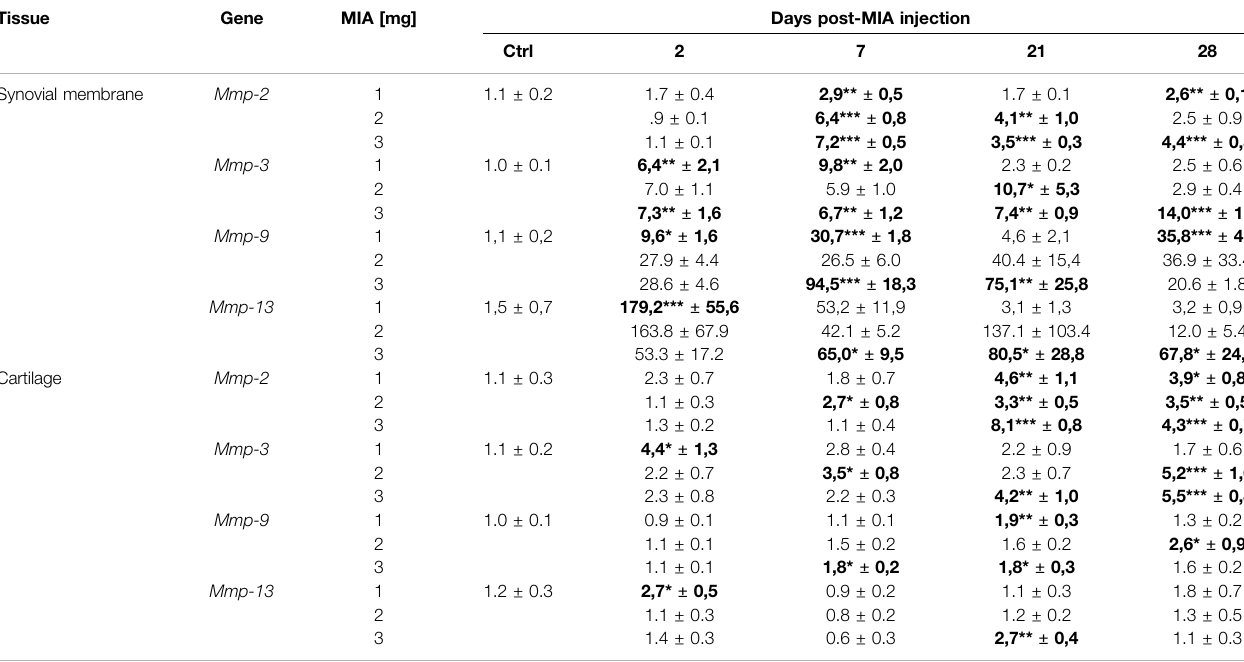
TABLE 1 | Transcript abundance levels of selected genes in synovial membrane and cartilage samples from osteoarthritic rats. Tissue